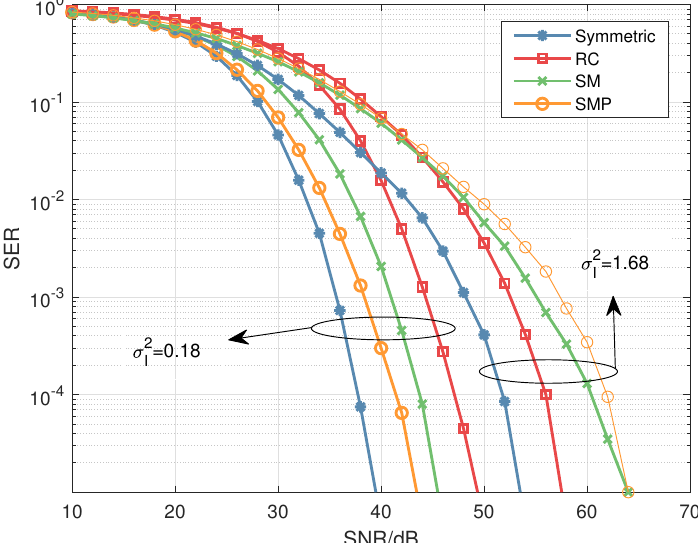
Figure 6. Reliability performance comparisons for the atmospheric